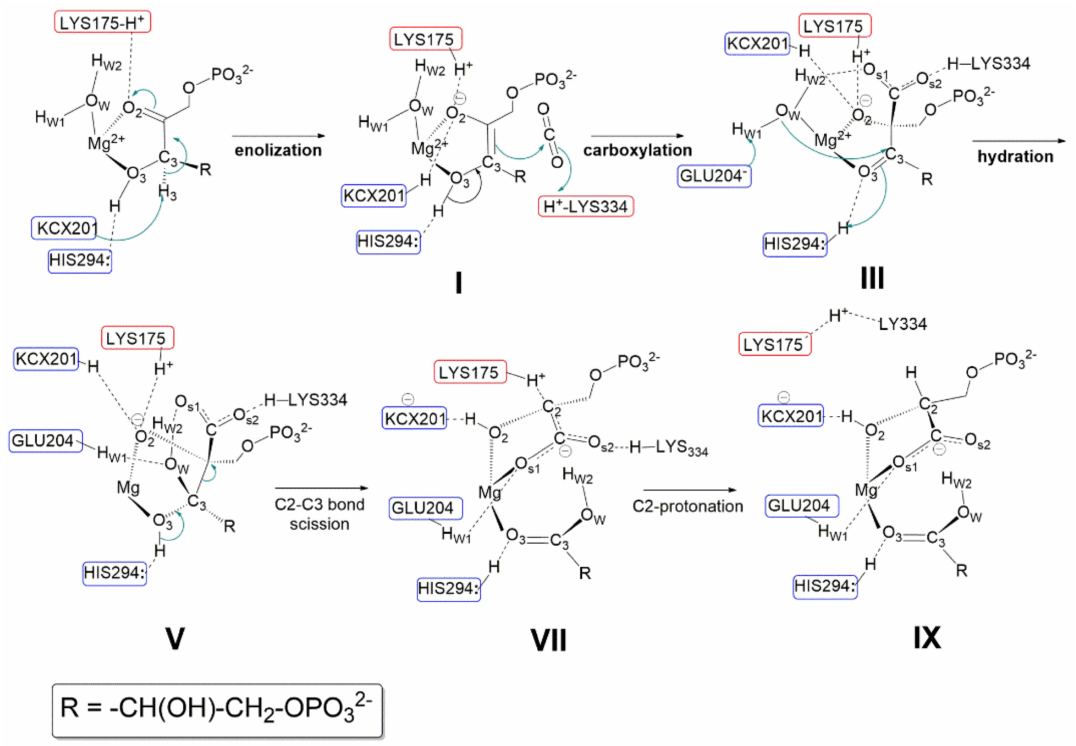
Figure 10. Proposed reaction mechanism for the conversion of RuBP at the Rubisco catalytic site. Amino acid residues acting as Lewis base are highlighted in blue boxes, while amino acid residues stabilizing anions through hydrogen bond are highlighted in red boxes. Numbering (I–IX) refers to geometries of local minima along the reaction pathway obtained using Gready’s theoretical model. (Figure from ref. [37], adapted and used by permission of American Chemical Society (copyright ©